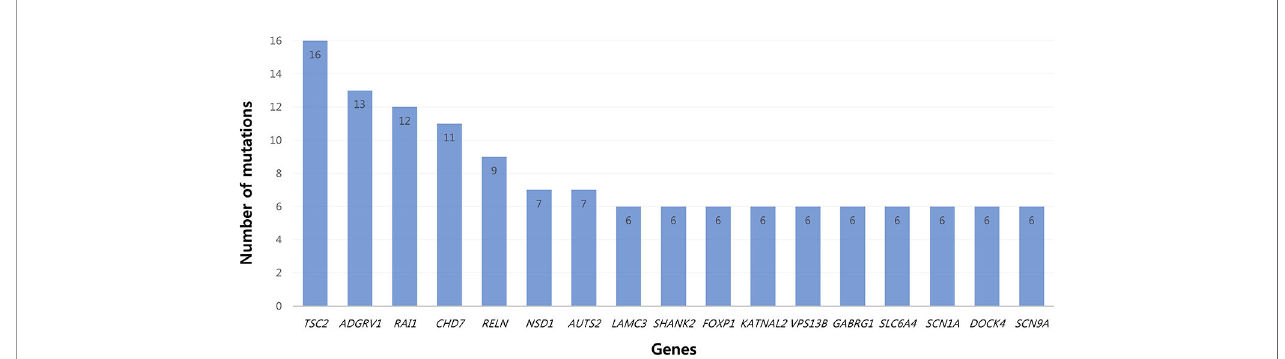
FIGURE 1 | Most common genes with variants of unknown signi fi cance. Among genes with VOUS, TSC2 (16 times) was most frequently observed. After TSC2 , common genes appeared in the order of ADGRV1 (13), RAI1 (12), CHD (11), RELN (9), NSD1/AUTS2 (7) and LAMC3/SHANK2/FOXP1 / KATNAL2/VPS13B/